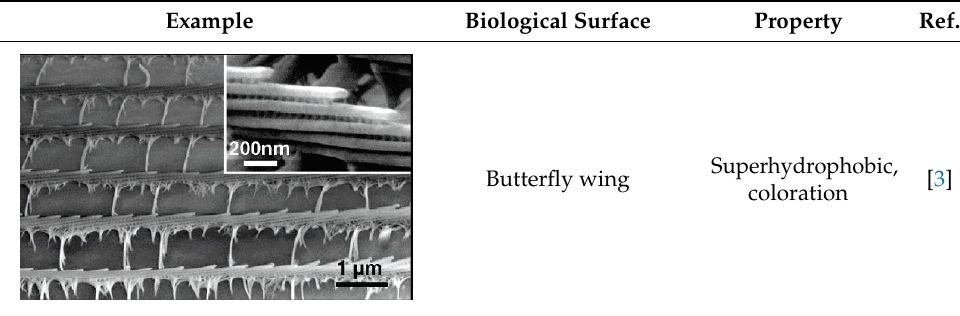
Table 1. Examples of nano- / micro-textured biological surfaces.